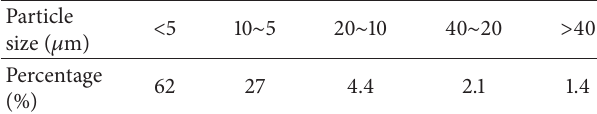
Table 3: Particle distribution of